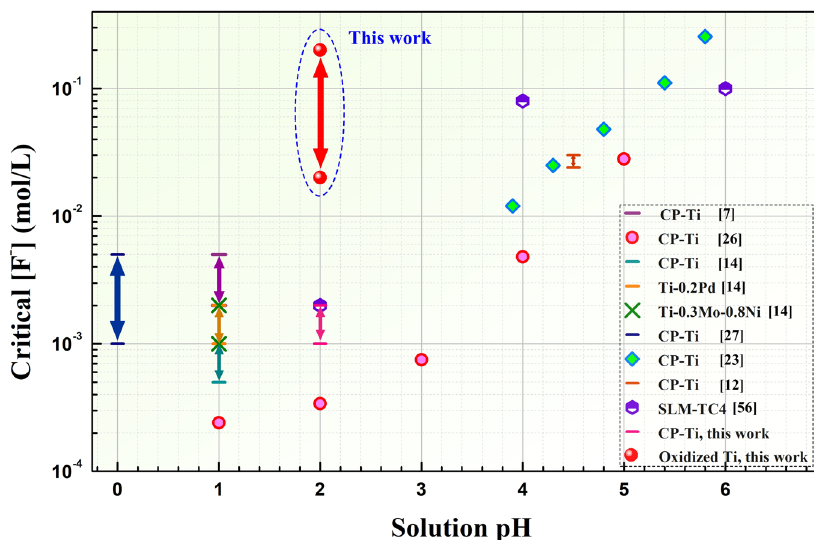
Fig. 12 Differences in critical [F − ] between this work and the literature. Summary of the critical [F − ] in the literature.